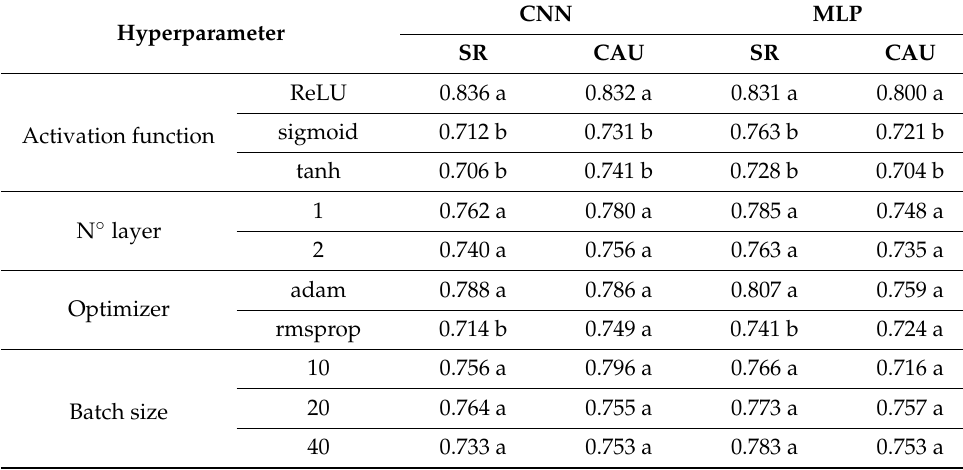
Table 2. Average classification accuracy of each hyperparameter in the classification of the population structure of wheat through MLP and CNN